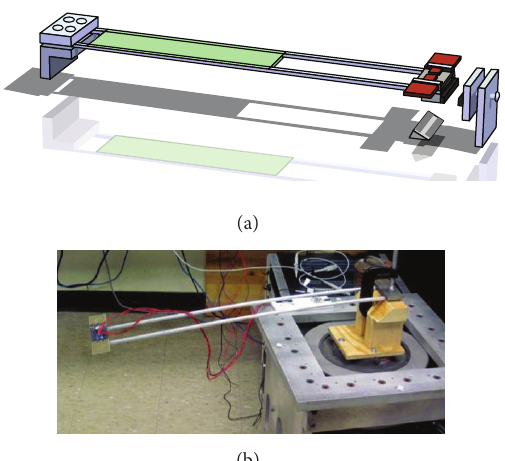
Figure 14: PE-VEH developed by [15]: (a) CAD model of PE-VEH prototype and (b) developed PE-VEH on the vibration shaker.